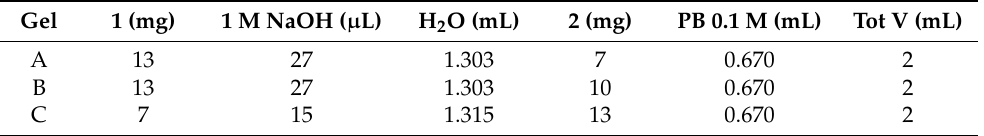
Table 3. Quantities used in the preparation of gels A – C prepared with different amounts of gelators